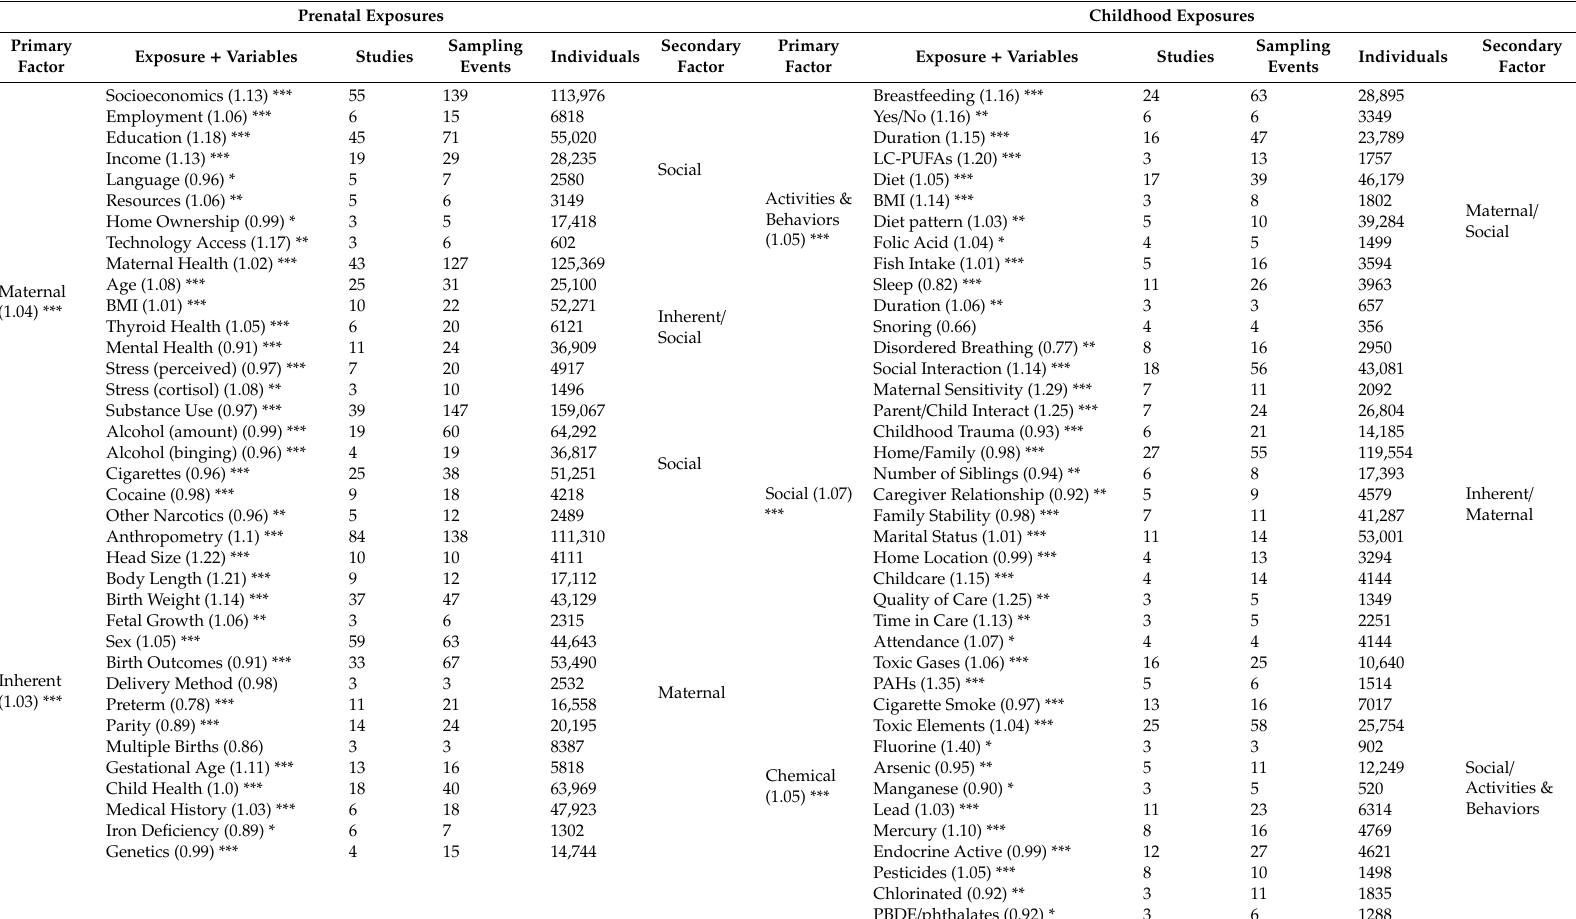
Secondary Sampling Individuals Factor Events